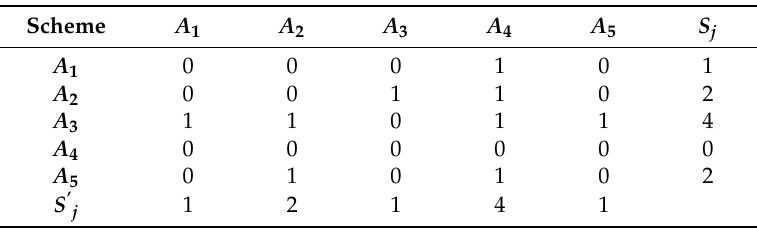
Table 2. N × N matrix used in the Borda ranking